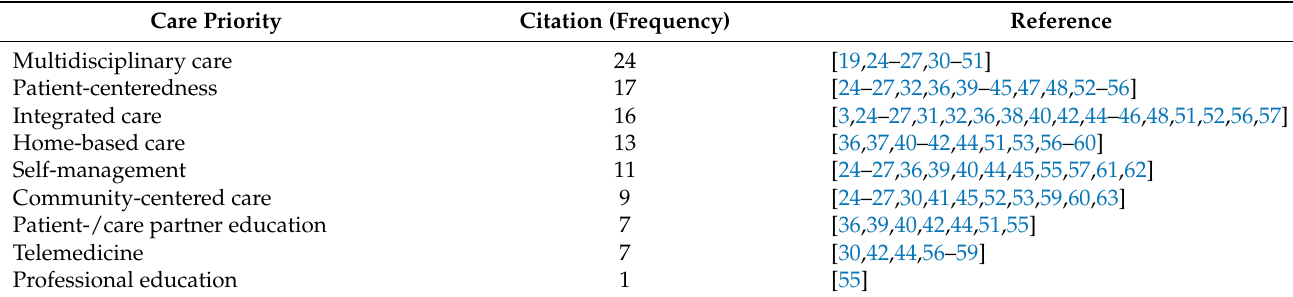
Table 2. Care Priorities for Parkinson’s Disease in Practical Care Concepts.